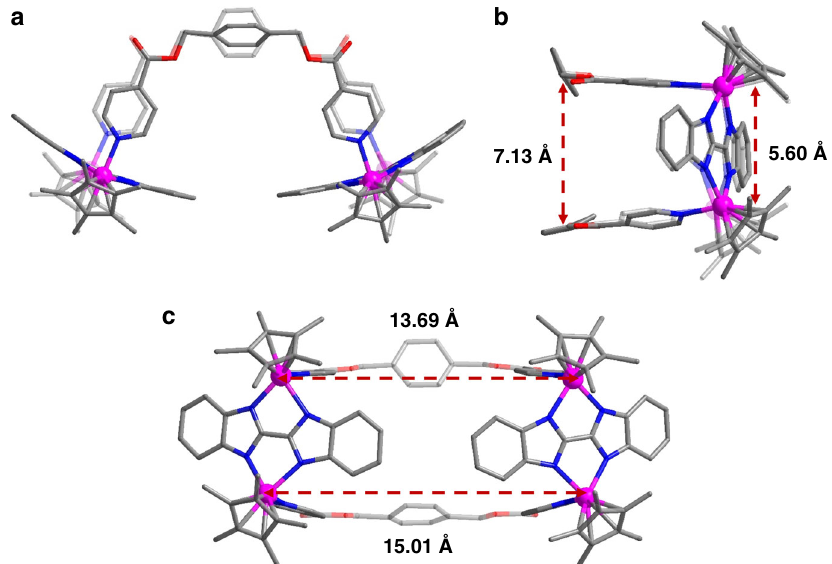
Fig. 4 Single-crystal X-ray structure of 2a . Top view ( a ), side view ( b ), and front view ( c ). Counteranions and hydrogen atoms are omitted for clarity (N, blue; O, red; C, gray; Rh, purple)